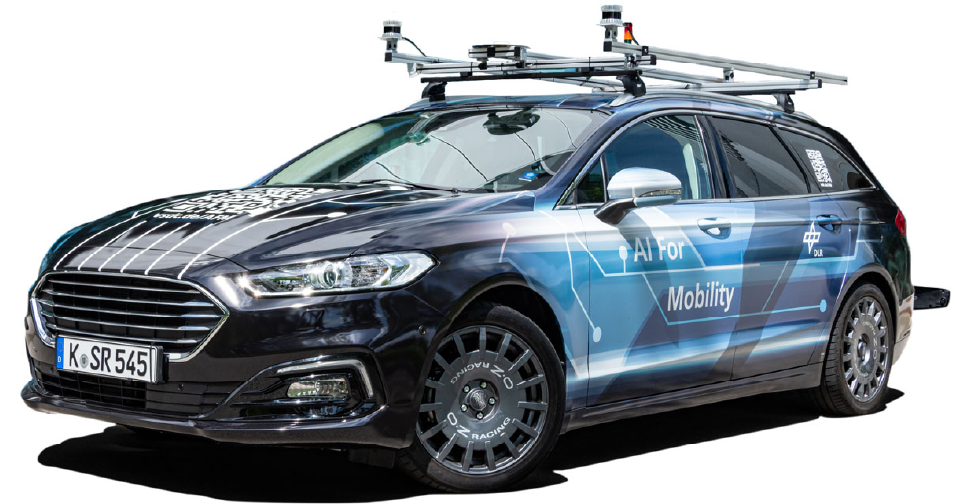
Figure 1. The AFM test vehicle.